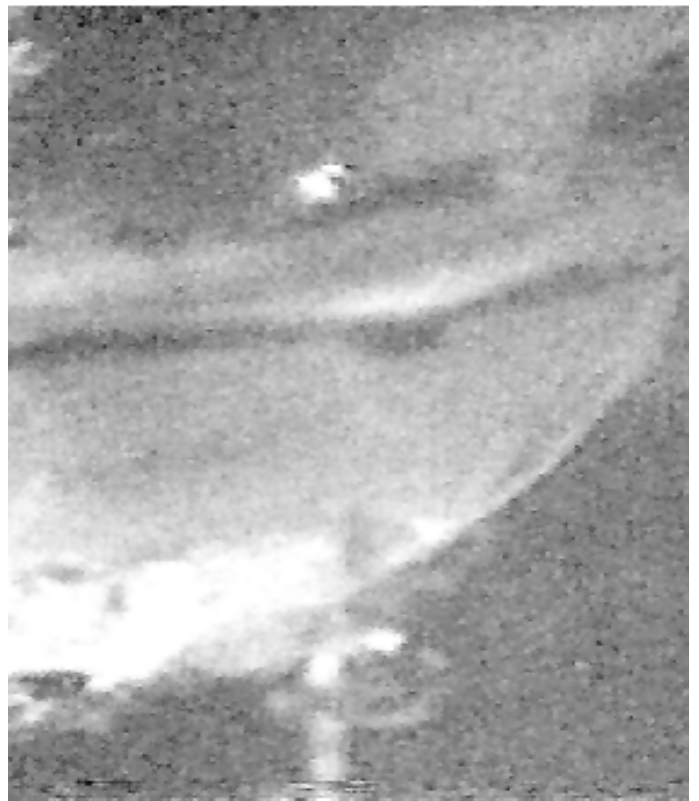
Fig. 6 – Detail of the laser beam touching the tip and shaft of the tungsten electrode inside the lens and leaving the lens below. Between these two points, the tissue is